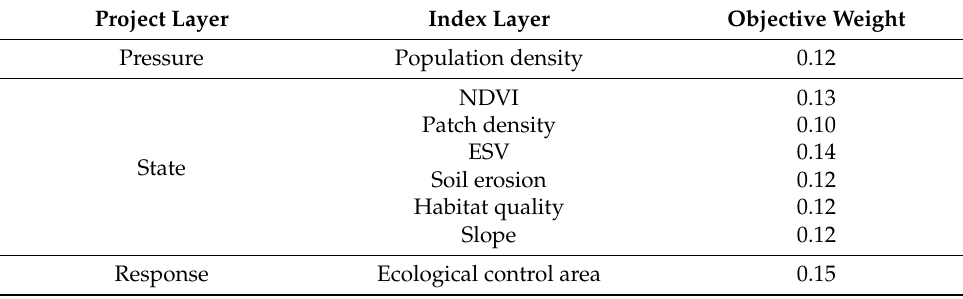
Table 3. The evaluation index system of YRD ecosystem.